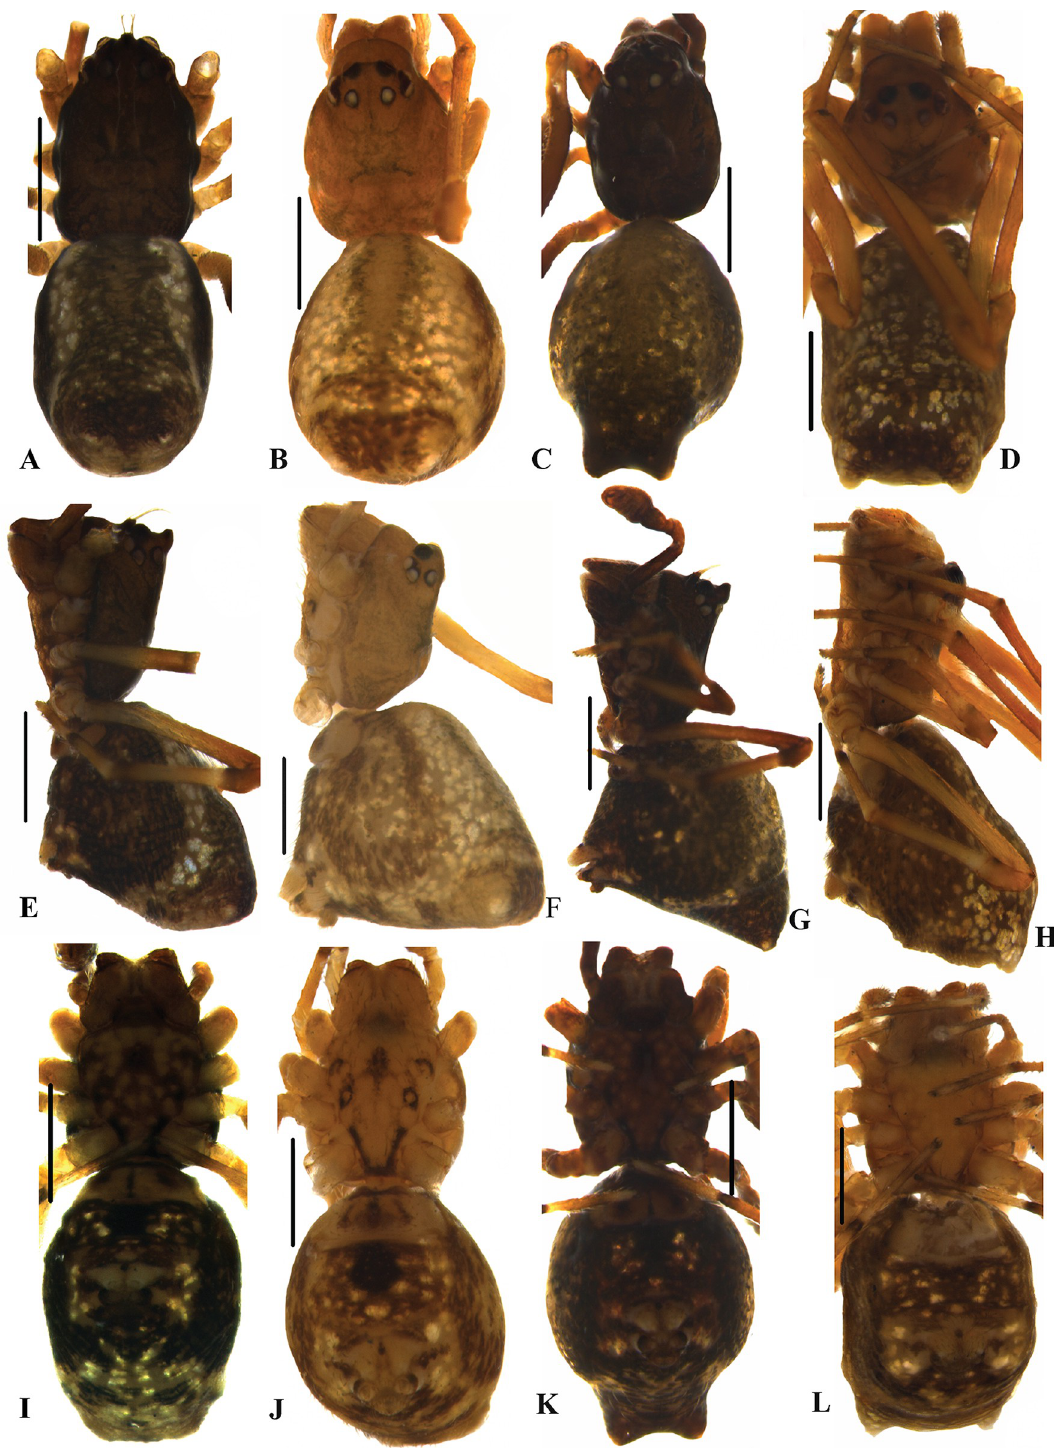
Fig 8. Habitus of Neospintharus species of Sri Lanka. A–B, E–F, I–J N . kandelensis sp. nov. A, C, E, G, I, K male habitus; B, D, F, H, J, L female habitus. C–D, G–H, K–L N . ohiyiaensis sp. nov. A–D dorsal view; E–H lateral view; I–L ventral view. Scale bars = 0.5 mm